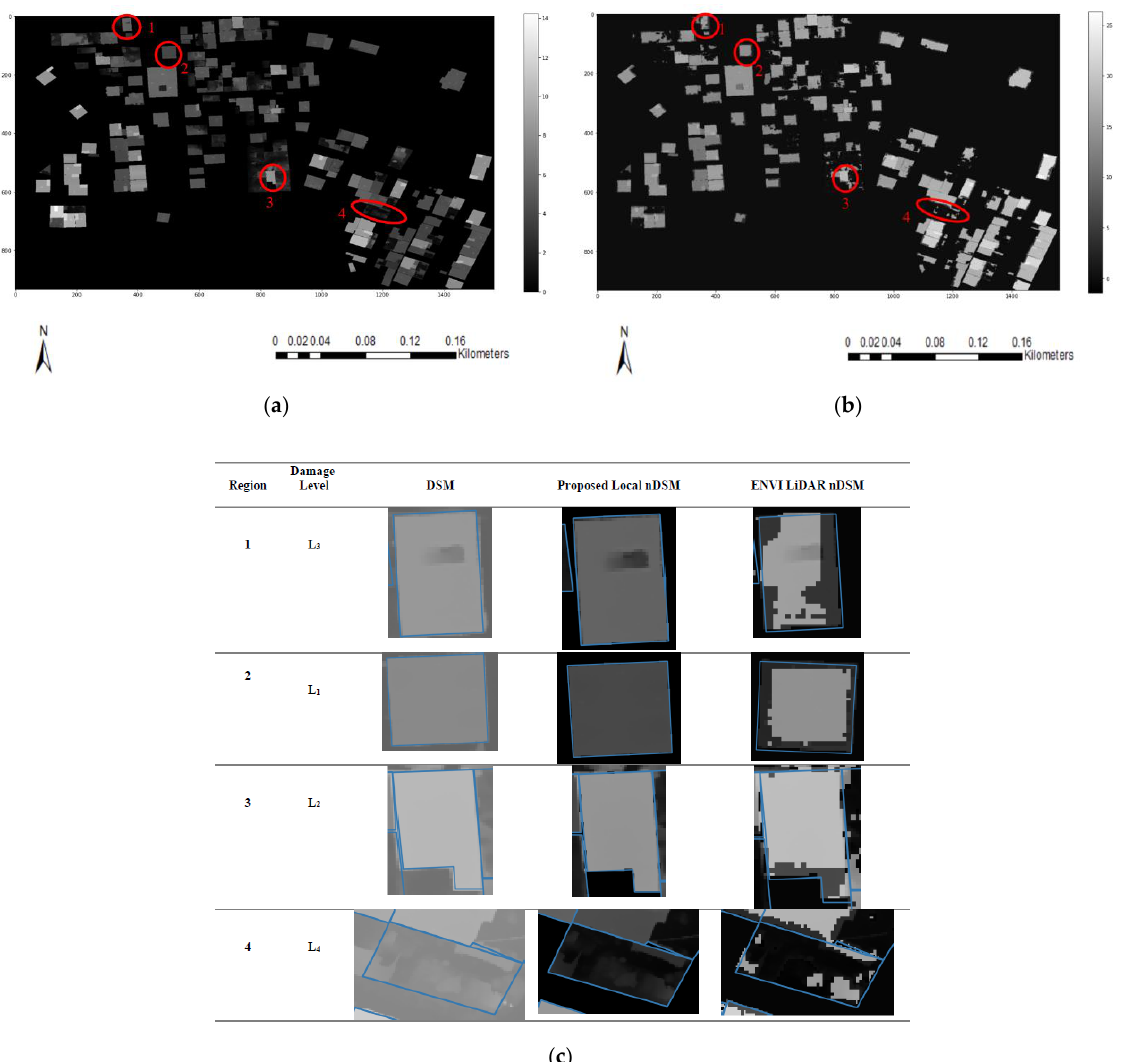
Figure 5. Comparison of the accuracy of nDSM: ( a ) Proposed local nDSMs, ( b ) ENVI LiDAR nDSM, ( c ) Zoomed regions over different damage levels.